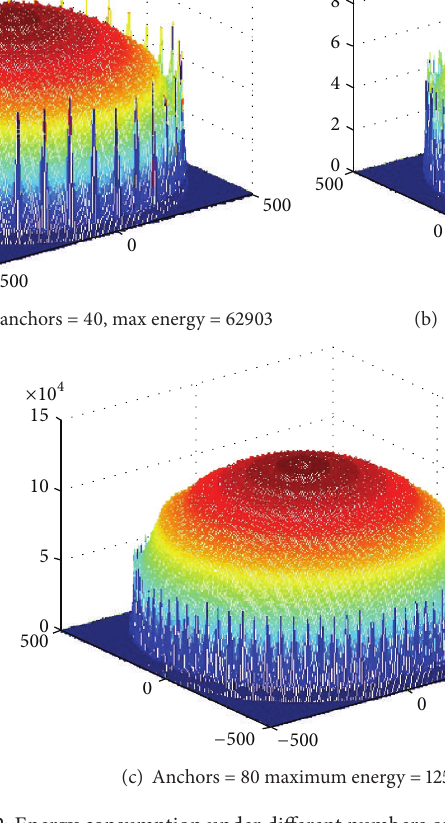
Figure 22: Energy consumption under different numbers of anchor (theoretical